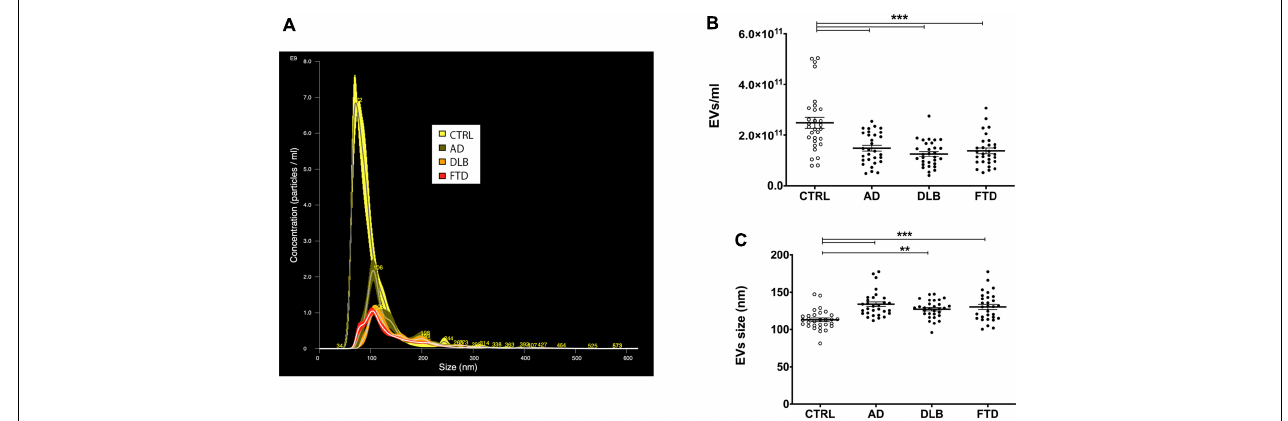
FIGURE 1 | EVs concentration and size in patient and control groups. (A) Representative spectra from NTA of CTRL (yellow), AD (green), DLB (orange), and FTD (red) plasma EVs. (B) Quantification of EVs concentration with NTA in CTRL, AD, DLB, and FTD plasma samples. A statistically significant decrease in EVs concentration was observed in the three pathological groups compared to controls. (C) Representation of EVs size measured with NTA in CTRL, AD, DLB, and FTD plasma samples. An increase in size was observed in AD, DLB, and FTD compared to CTRL samples. Average ± SEM; ** p < 0.01, *** p < 0.001, one-way ANOVA with Bonferroni’s post